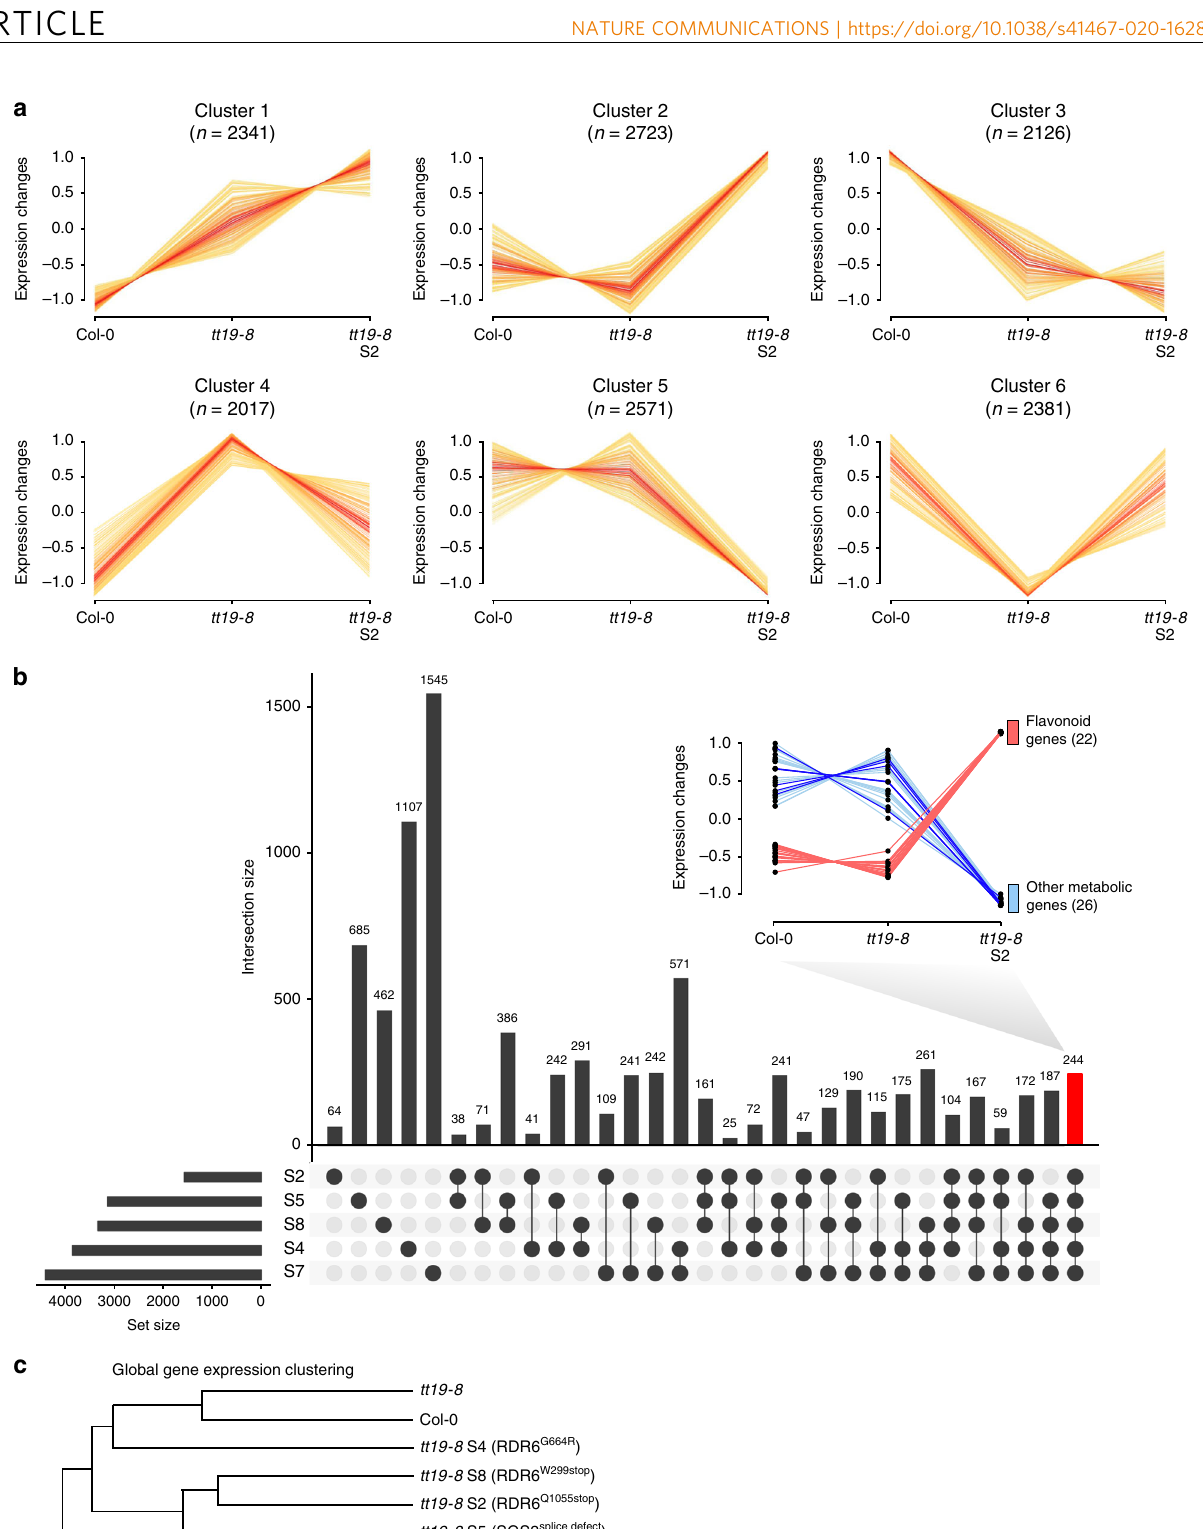
only ~10% of the anthocyanin content of wild-type plants (Fig. 1a). Gene expression patterns in the tt19 suppressor lines were rather different from both tt19-8 and Col-0. Gene ontology enrichment of K -means clusters showed that a large number of genes (captured